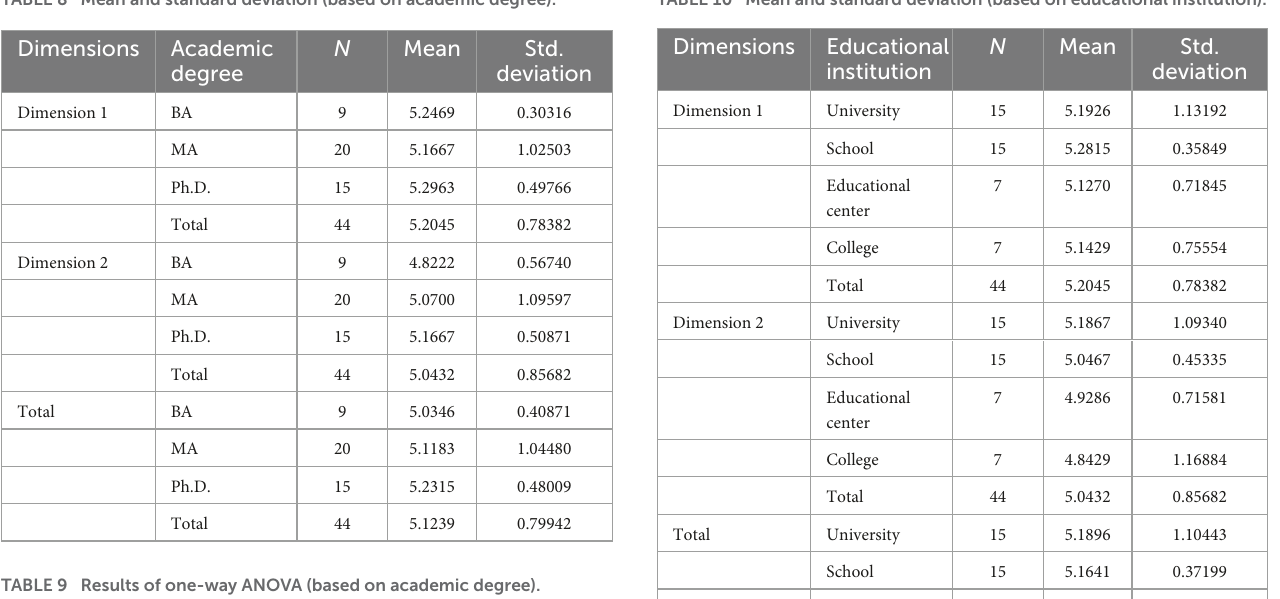
TABLE 10 Mean and standard deviation (based on educational institution).